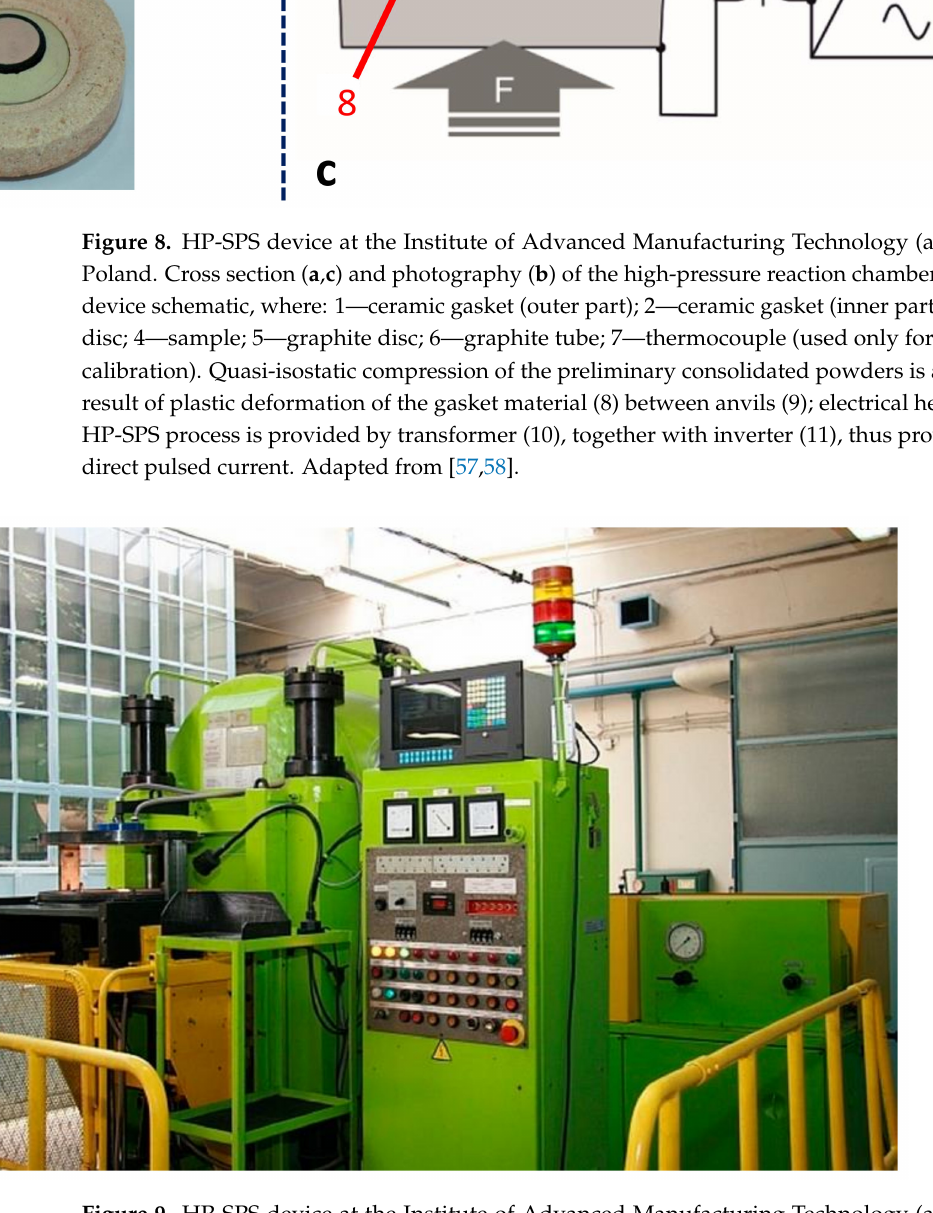
Figure 9. HP-SPS device at the Institute of Advanced Manufacturing Technology (at Krakow) in Poland (from